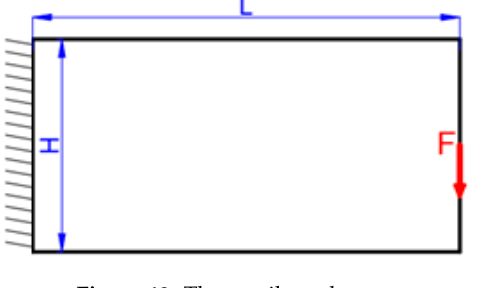
Figure 13. The cantilever beam.